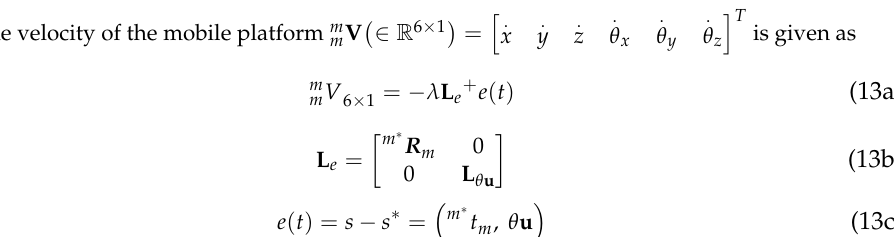
Figure 10. Frames definition for visual-servo control. The symbol (*) is used to represent the desired positions.